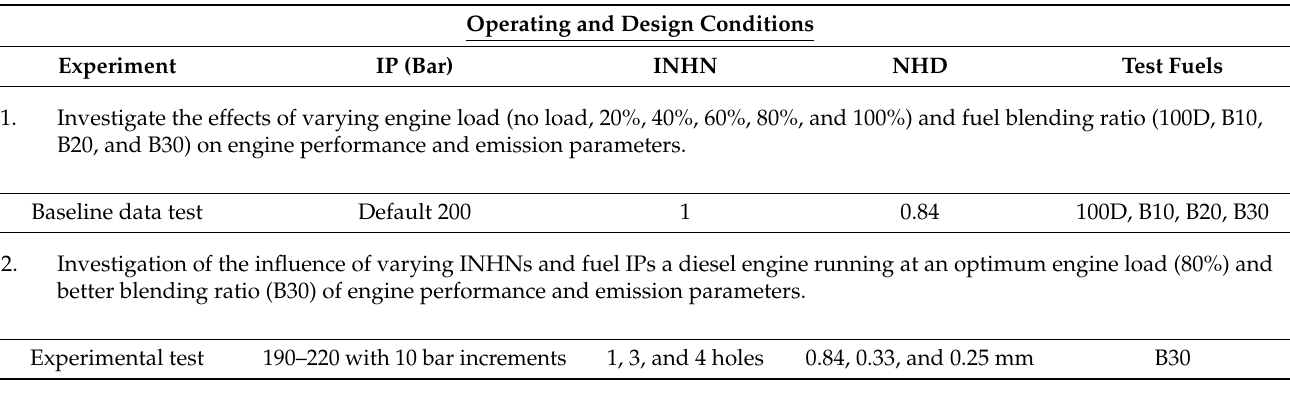
Figure 9. Different injector nozzles photograph. Table 6. The test matrix for the experimental